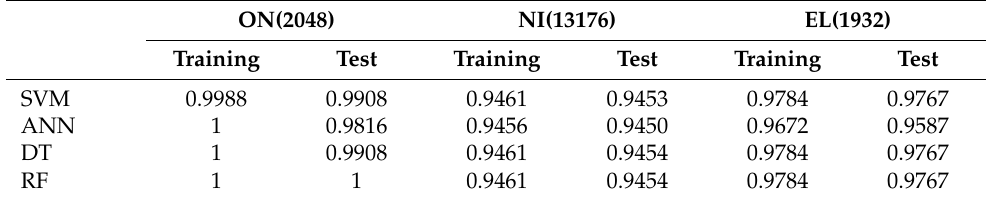
Table 10. Optimal classification results for a single different